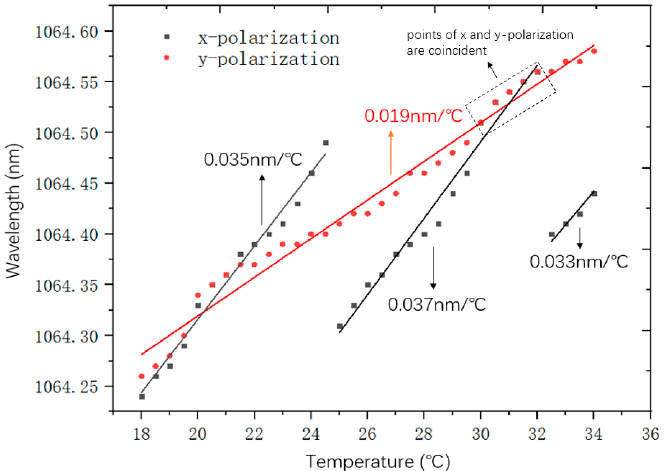
Figure 2. Variations of the wavelengths of the dual-frequency components with temperature increasing from 18°C to 34°C. The points of x- and y-polarization are approximately overlapped between 30°C and 32°C.